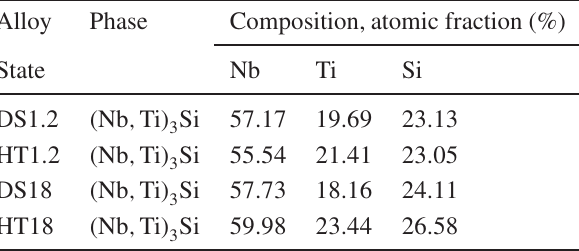
Table 1. Compositions of the Nb3Si phases in DS and HT samples determined by EDS